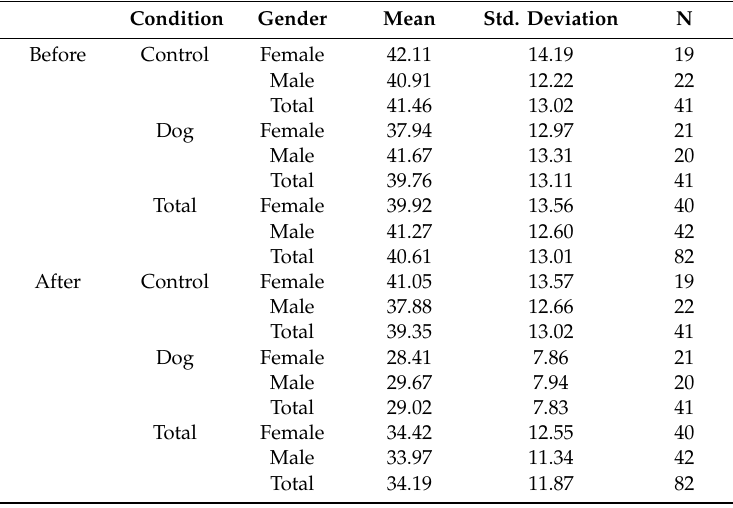
Table 6. Descriptive Statistics: Anxiety and